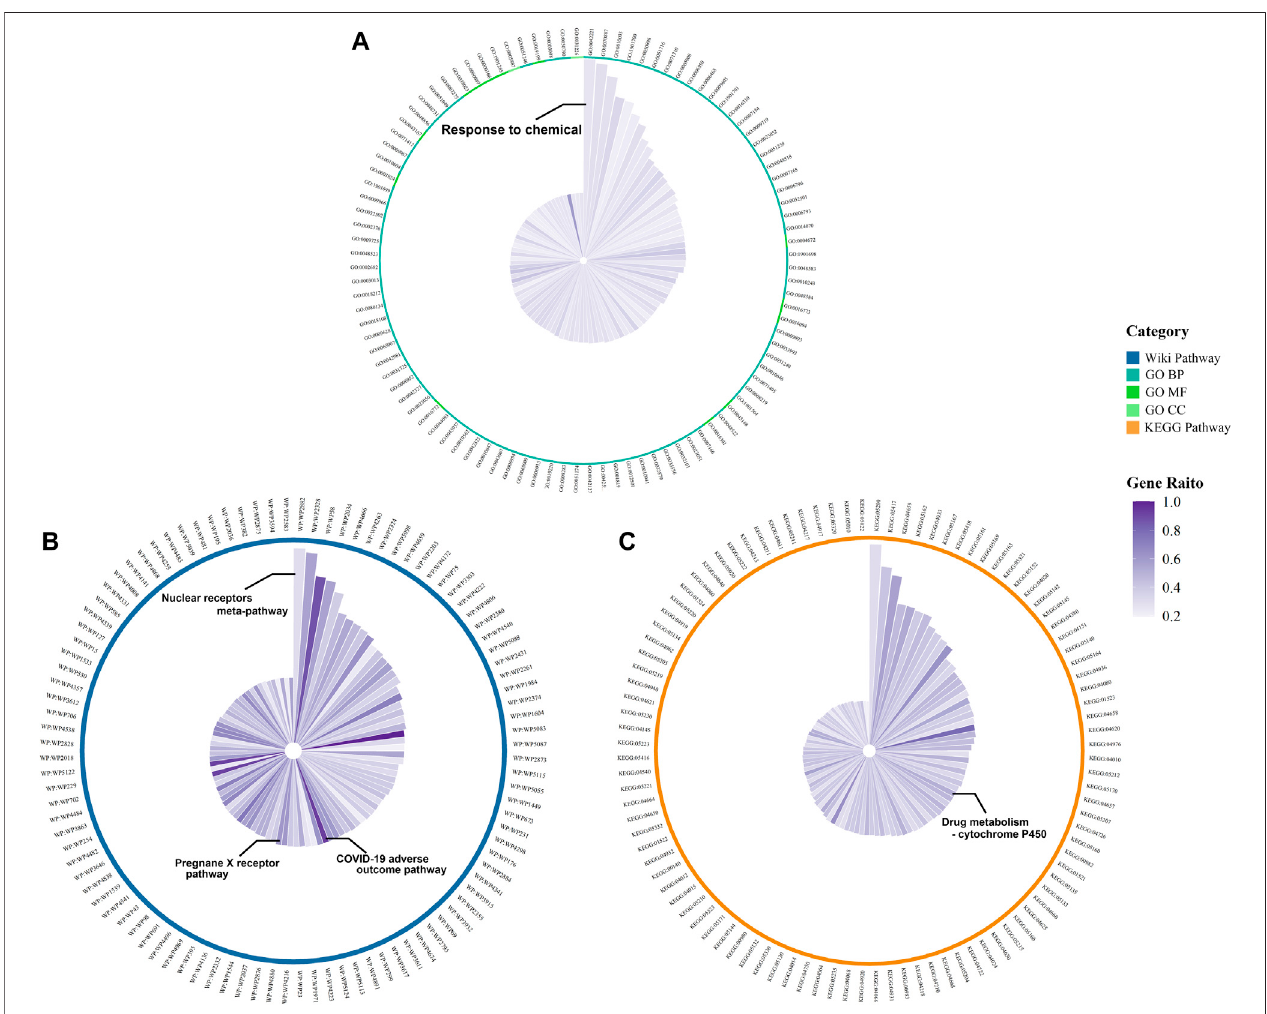
FIGURE 3 | Functional enrichment results of DPTSGs: Top 100 GO terms (A) , KEGG pathways (B) , and WP pathways (C) (The radius of the circle is the -log 10 p value of the term).